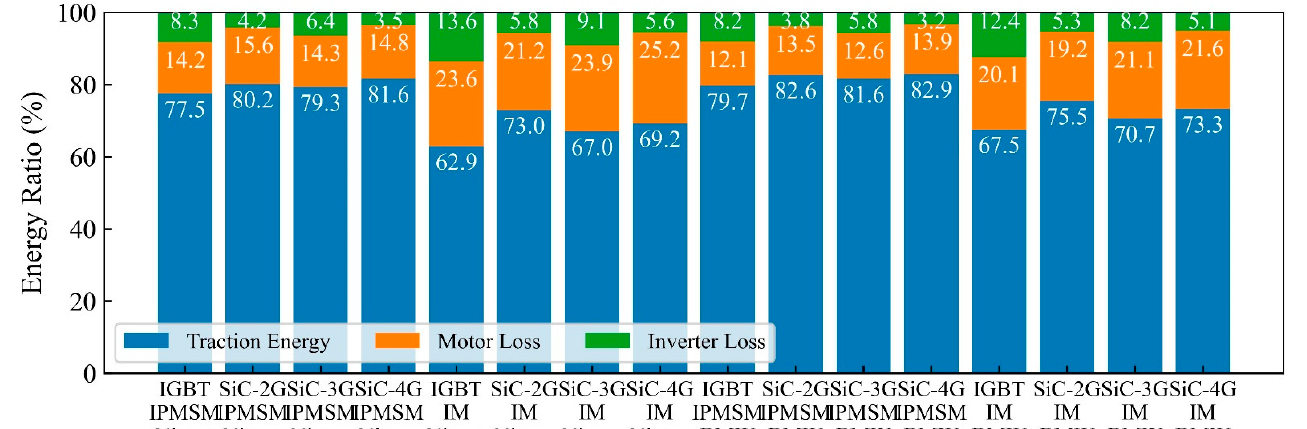
Figure 6. Energy consumption ratio of each experimental case.